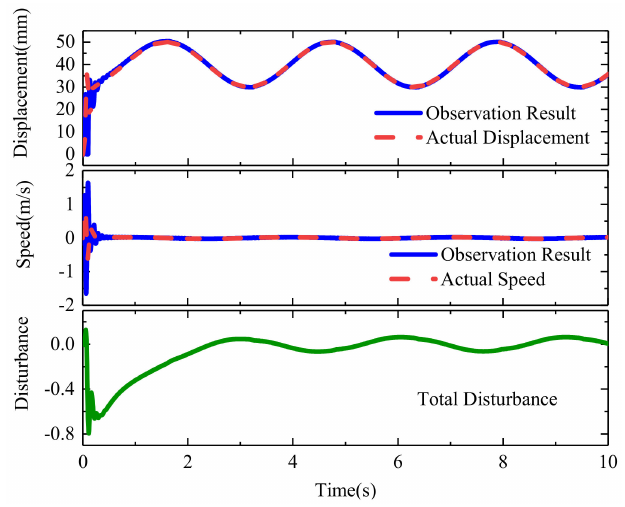
Figure 19. Error and controller output.